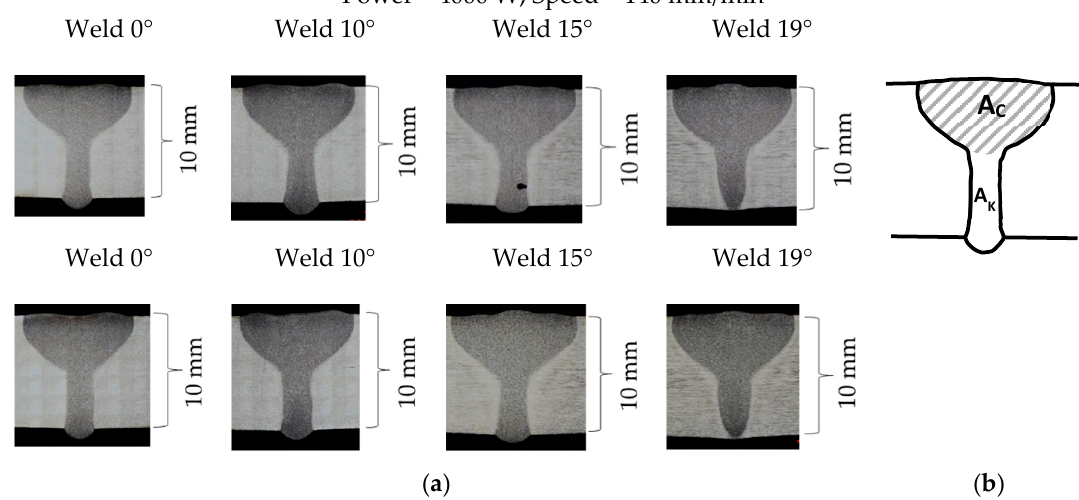
Figure 6. ( a ) Cross sections of the four BOP-welds. Each cross section has been replicated twice. ( b ) Generic representation of a laser weld bead, which can be divided in two main areas: conduction area (A C ) and keyhole area (A K